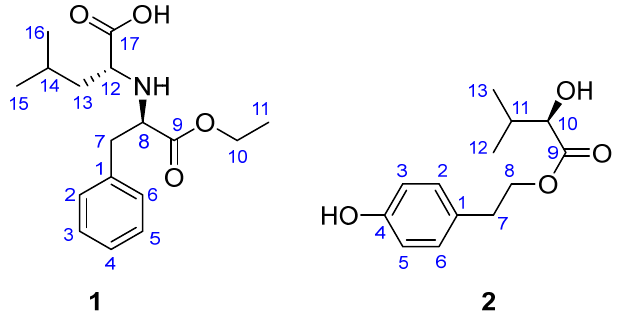
Figure 1. Structures of compounds 1 and 2 .